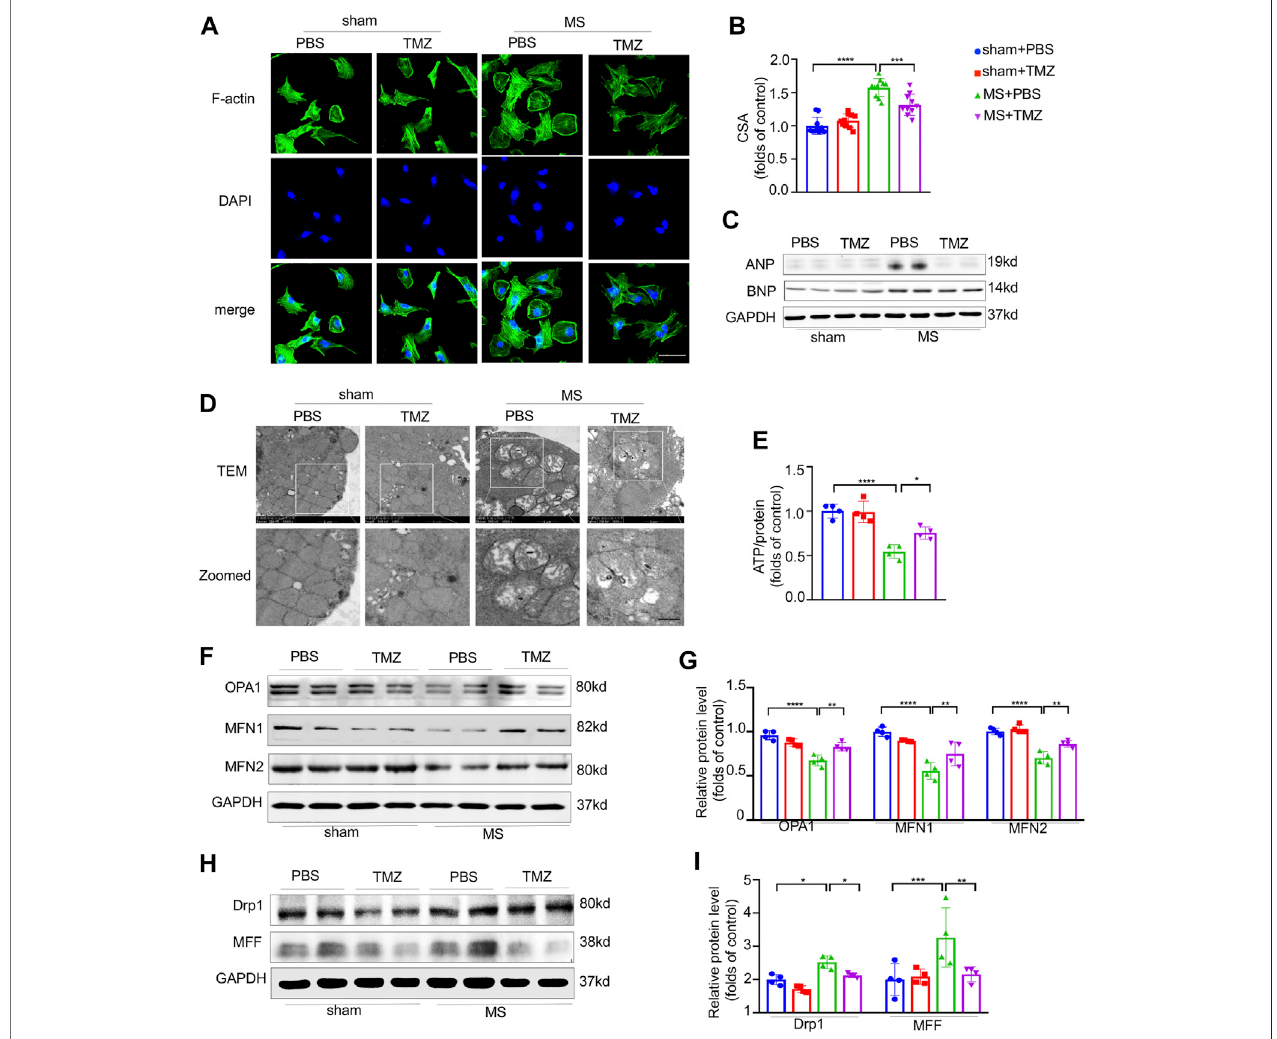
FIGURE4| Trimetazidineinhibited thepressureoverload-evokedmyocardialhypertrophyand mitochondrialdysfunction invitro . (A) Immuno fl uorescence staining of F-actin in NRCMs, nuclei were stained with DAPI, scale bar (cid:2) 50 um. (B) NRCM area calculated from (A) , each group included 10 cells. (C) The protein levels of ANP and BNP in NRCM and their quantitative data collected from four independent samples. (D) Representative ultrastructure mitochondrial image of NRCMs. scale bar (cid:2) 0.5 um. (E) The ATP content of NRCMs ( n (cid:2) 4). (F,I) Representative western blots of mitochondrial dynamic protein and corresponding quantitative results. Graphical data are shown as mean ± SEM. Two-way ANOVA was used for analysis. * p < 0.05, ** p < 0.01, *** p < 0.001, **** p < 0.0001, vs indicated group. MS, Mechanical stretch; TMZ, Trimetazidine.